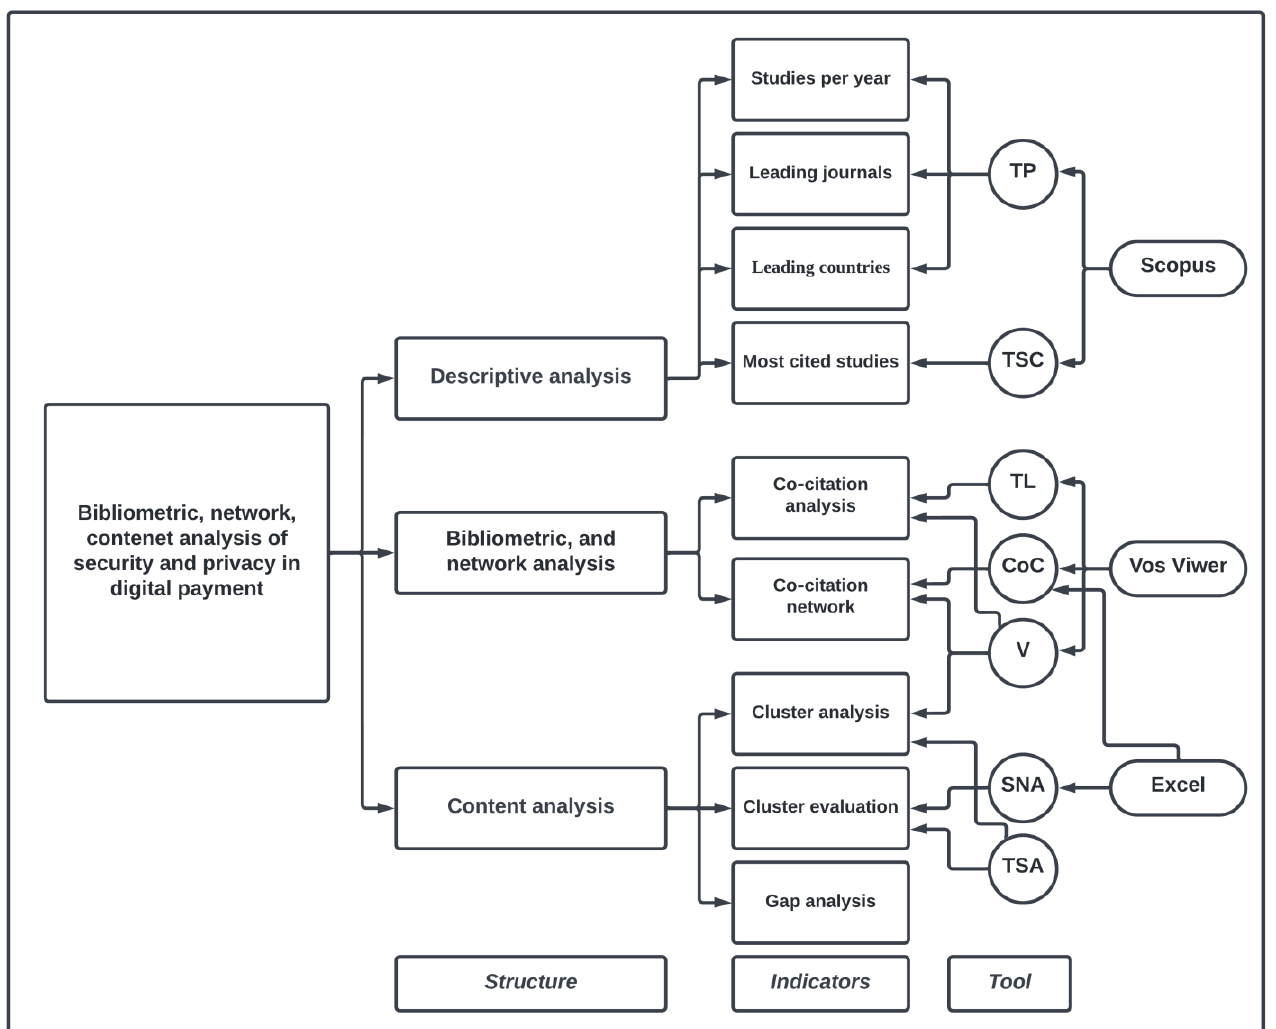
Figure 2. The analytic structure of this paper.